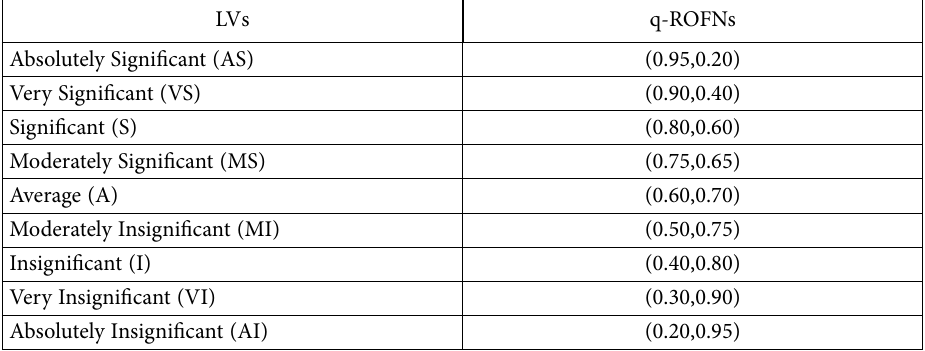
Table 2. Ratings of options and IoT risks in terms of LVs